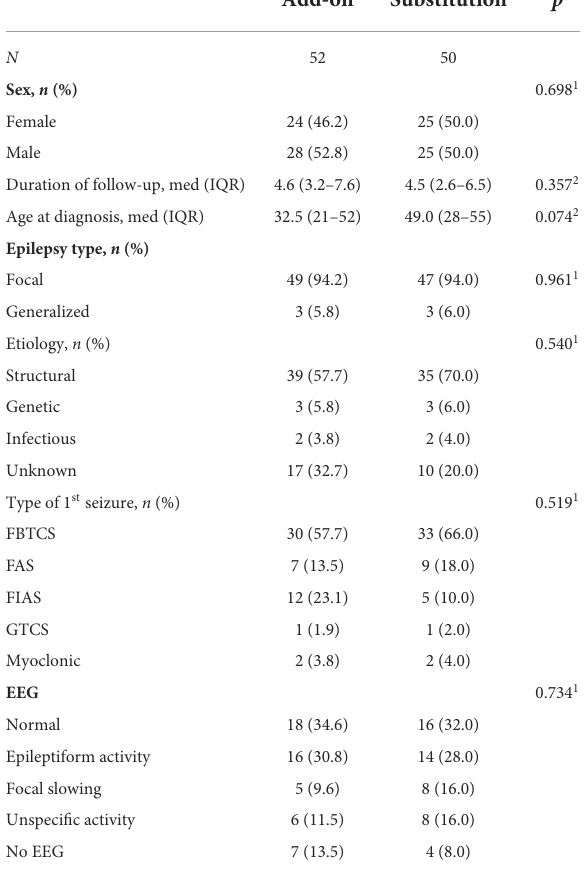
TABLE 4 Baseline characteristics of the patients when the first ASM was substituted or another ASM was combined (add-on) because of lack of